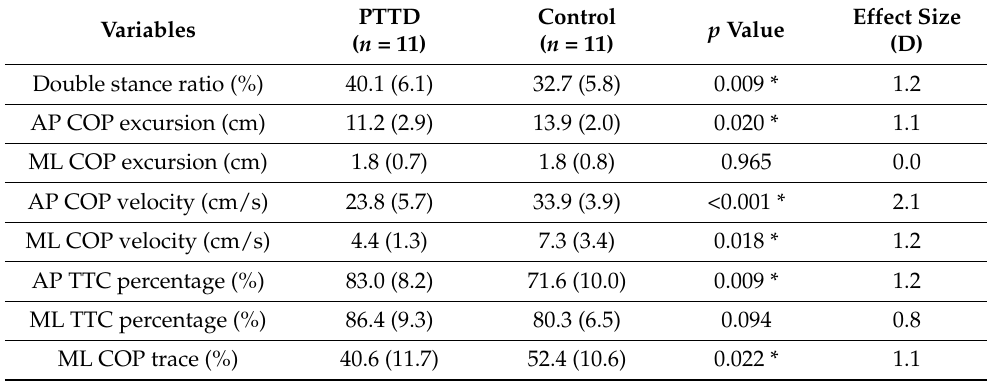
Table 2. Mean and standard deviations for double stance ratio and COP based